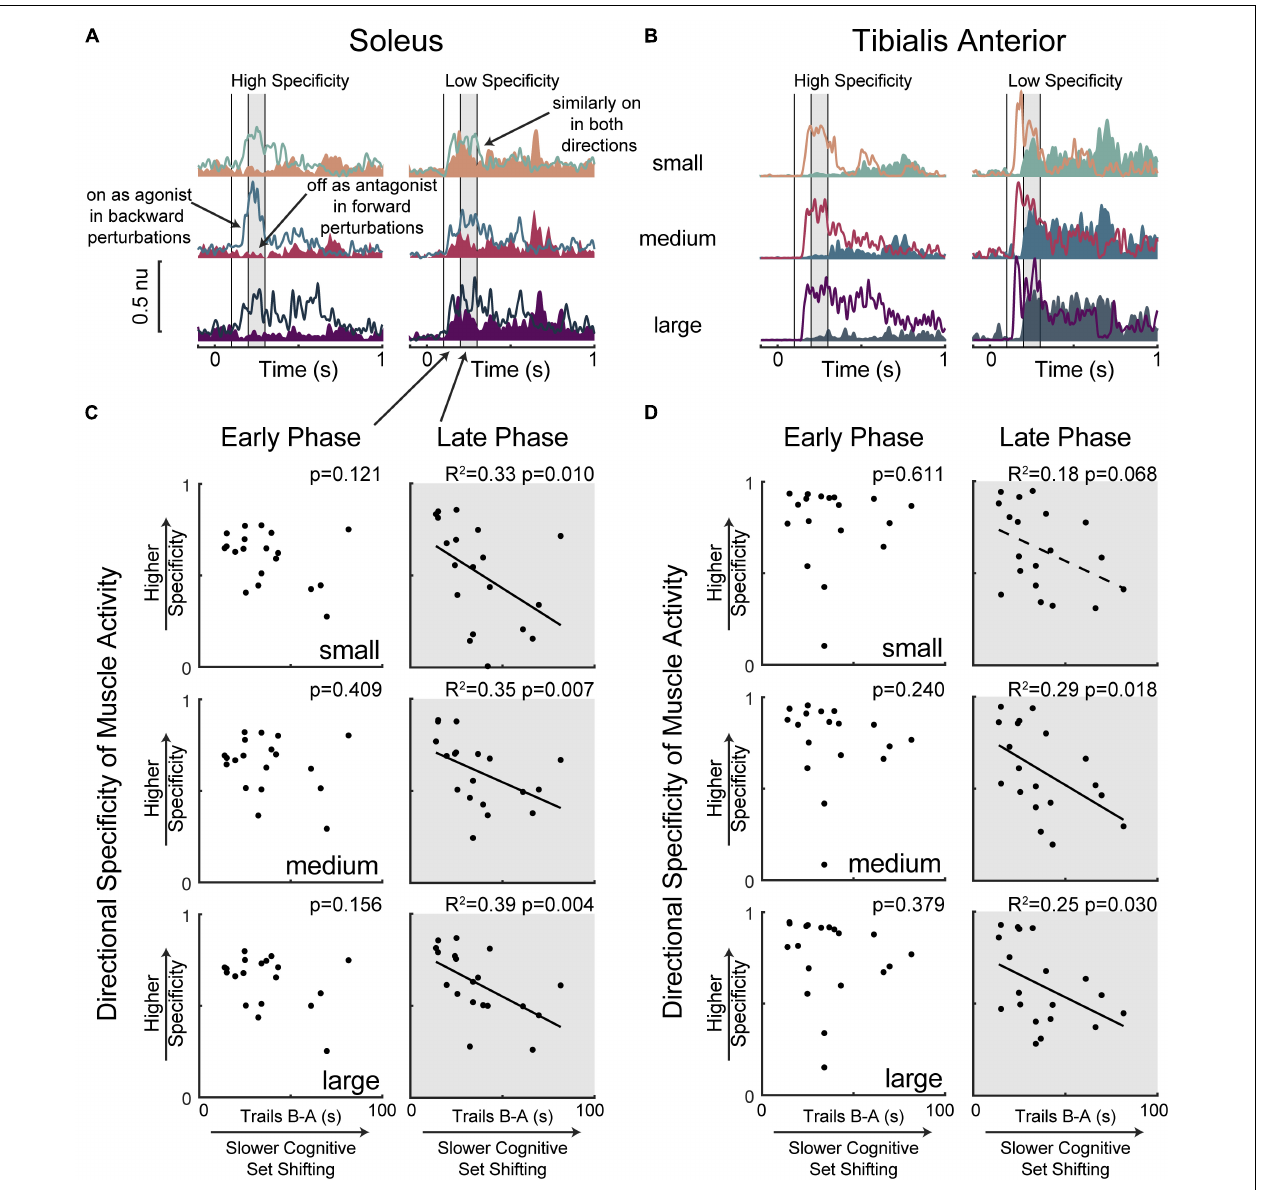
FIGURE 4 | Slower cognitive set shifting was associated with lower directional specificity in the late phase of muscle activation. Condition-averaged muscle activity is shown for (A) soleus and (B) tibialis anterior muscles for example participants with higher or lower directional specificity scores. Muscle activity evoked by forward movements of the floor (resulting in backward leaning posture) is represented in magentas and activity evoked by backward movements of the floor is represented in blues, with darker colors for larger perturbations. Antagonist activity (i.e., soleus activity in forward perturbations and tibialis anterior activity in backward perturbations) is shaded for clarity. Vertical lines at 100 ms, 200 ms, and 300 ms mark the bounds of the time bins of interest. The later (200–300 ms) time bin is shaded in all panels. Directional specificity is plotted against cognitive set shifting scores for the (C) soleus muscle and (D) tibialis anterior muscle in